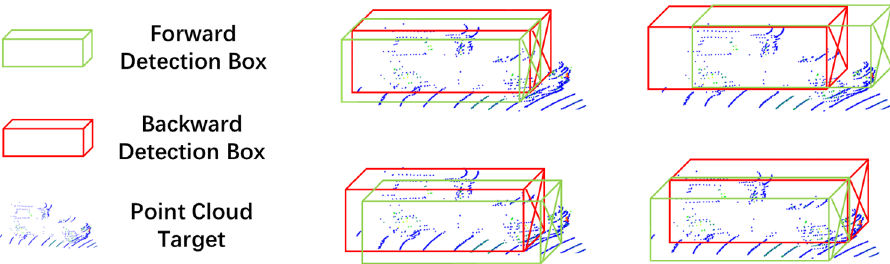
Figure 4. Examples of multiple detections of the same object across the seam.